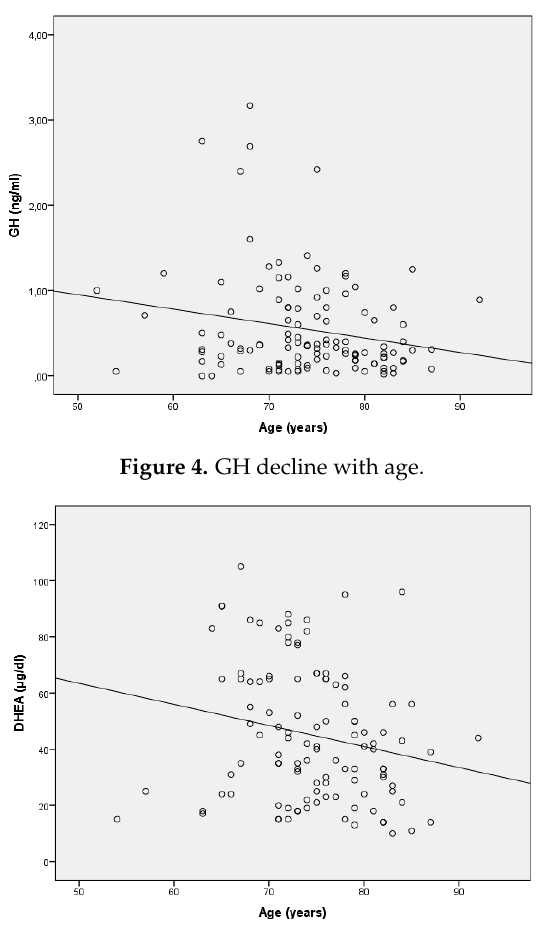
Figure 5. DHEA decline with age.